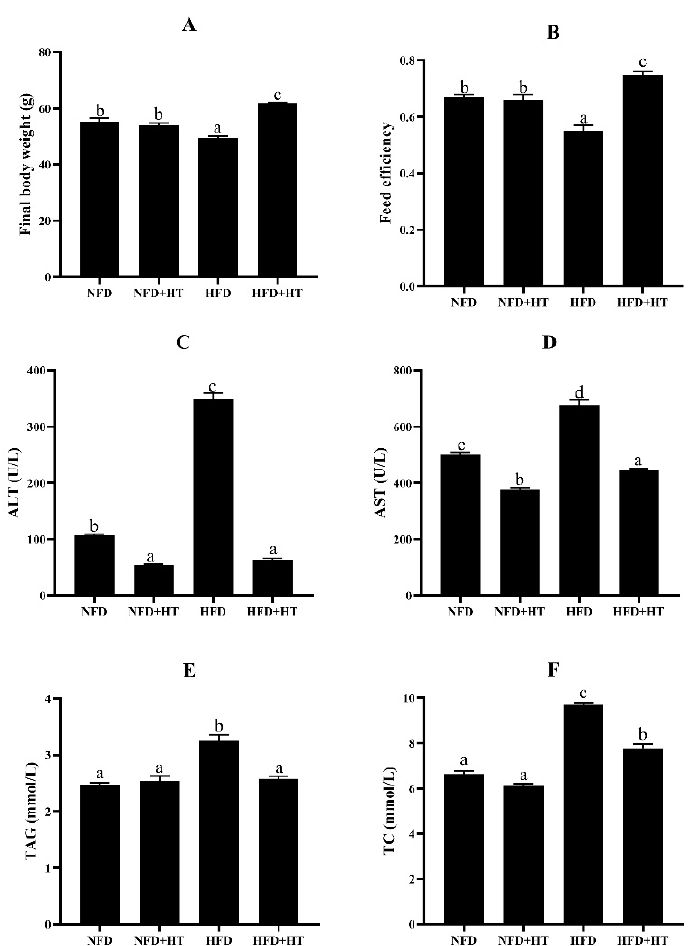
Figure 1. Final body weight ( A ), feed efficiency ( B ), plasma aspartate aminotransferase activity (AST: ( C )), alanine aminotransferase activity (ALT: ( D )), plasma triacylglycerol level (TAG: ( E )), and total cholesterol (TC: ( F )) content in spotted seabass ( L. maculatus ) fed the test diets for 8 weeks. All values are exhibited as mean ± SE. The values with different superscripts (a, b, c, d) are significantly different at p < 0.05 (Tukey’s test). Feed efficiency = wet weight gain/dry feed fed.